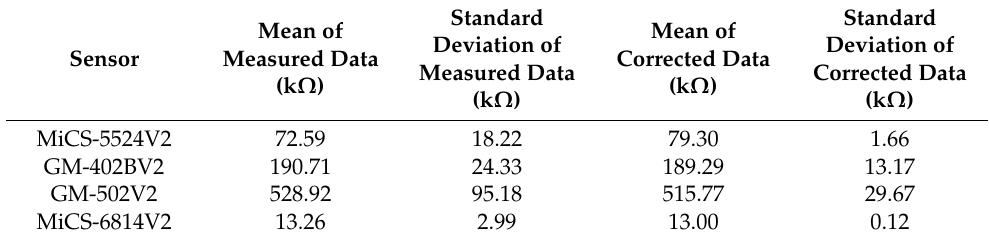
Table 2. Comparison of mean and standard deviation for measured and corrected